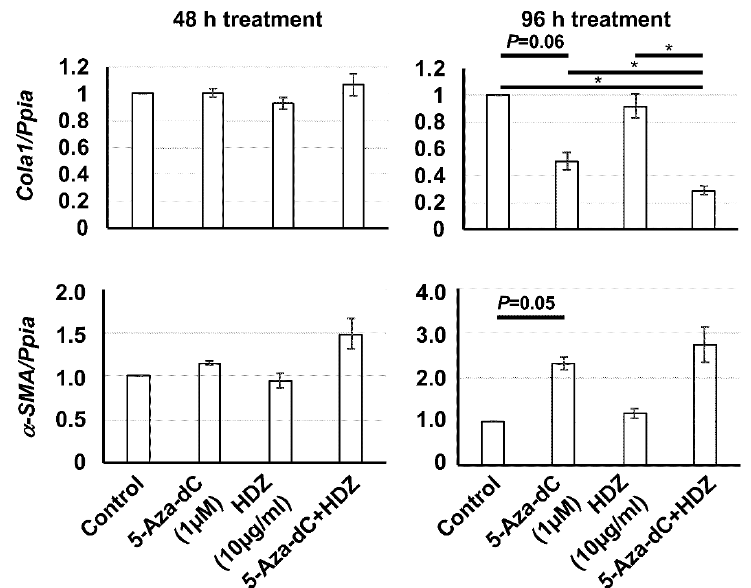
Figure 2. The mRNA expression levels of Cola1 and aSMA, fibrotic genes, in HSC-T6 cells treated with 5-aza-dC, HDZ, and 5-aza-dC and HDZ combined. The mRNA expression levels were measured using semi-quantitative RT–PCR. The e ff ects of 5-aza-dC, HDZ, and combined treatment with 5-aza-dC and HDZ were compared with untreated control cells. Data are the mean ± SD (n = 3). * p < 0.05 vs. the untreated